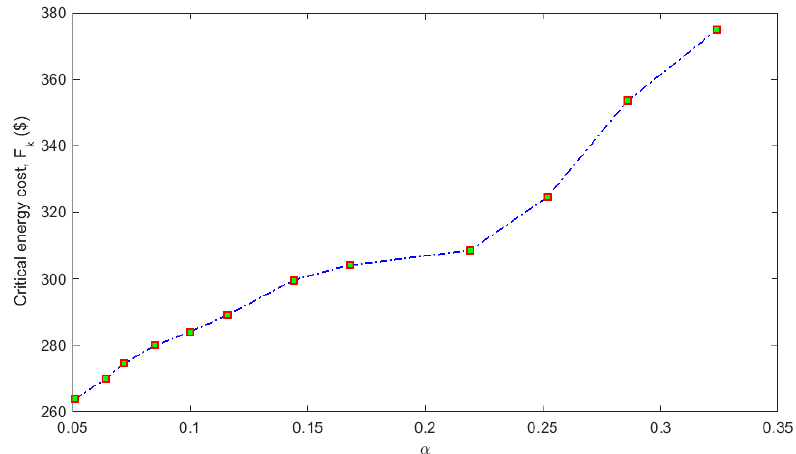
Figure 4. The optimum value of the cooling load increase at each scenario of the robust economic dispatch problem.